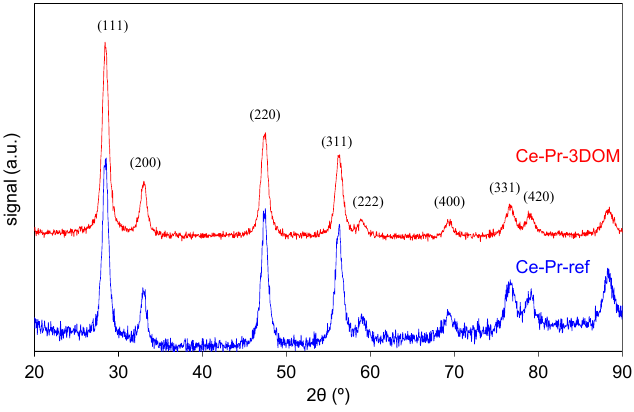
Figure 3. X ‐ ray diffractograms of the fresh catalysts.